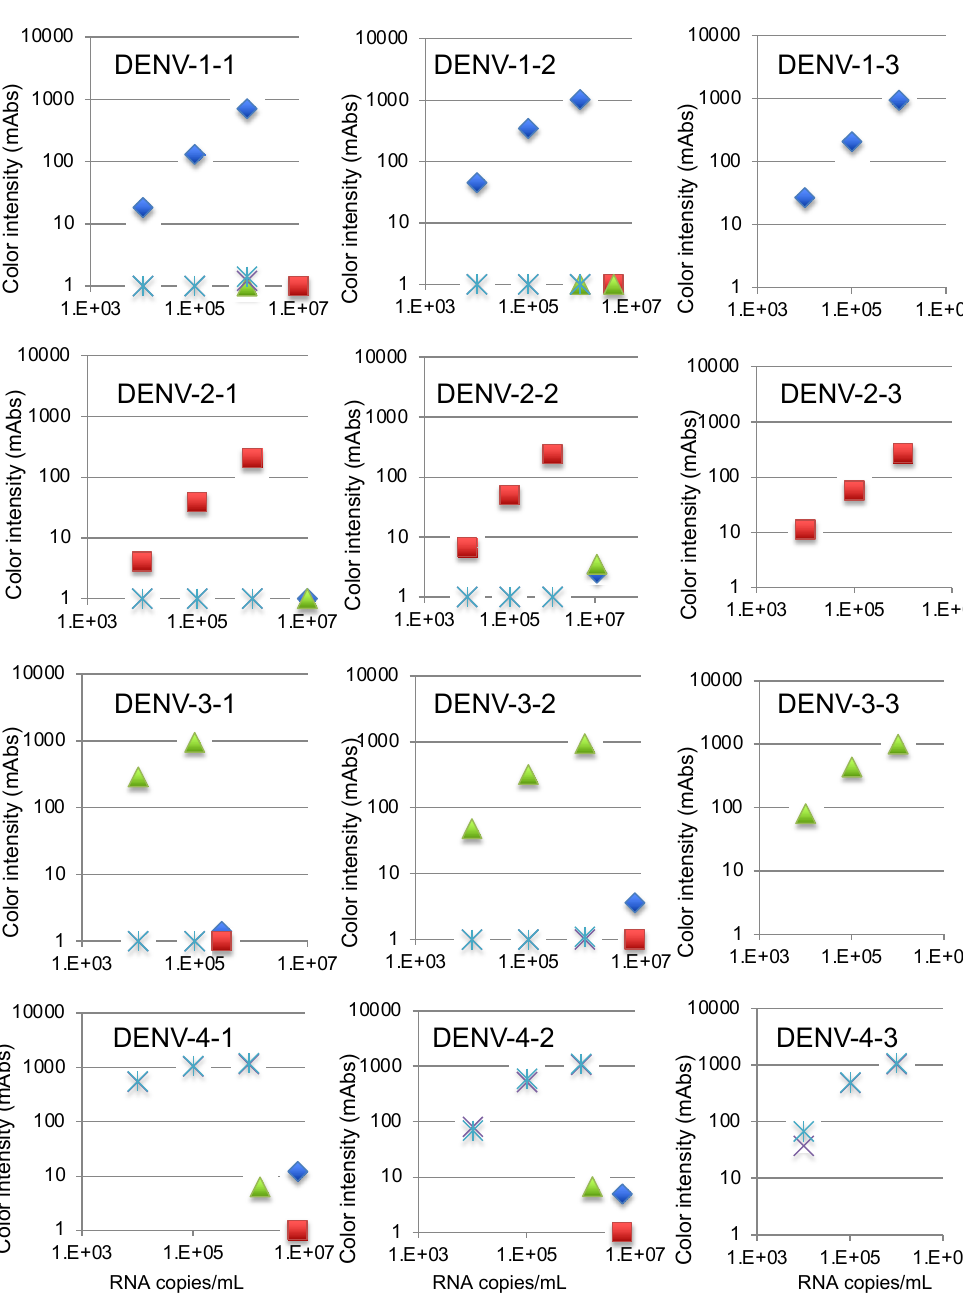
Figure 3. Evaluation of kit reactivity using clinical isolates from Thailand. The limits of detection for the DENV-1-specific (blue diamonds), DENV-2-specific (red squares), DENV-3-specific (green triangles), and DENV-4 #1 and #2-specific devices (purple crosses and blue asterisks) were defined by chromatographing dilutions of viruses with known titers (10 5 , 10 6 , and 10 7 copies/mL) and then quantifying the signal color intensity (mAbs: milli-absorbance). Each of the data points represents the result of a single device.